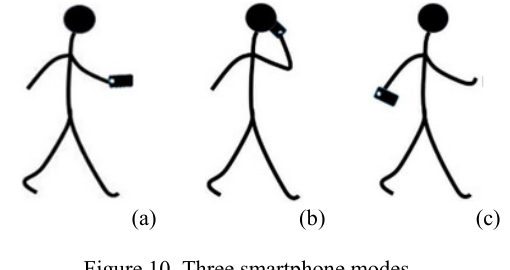
Figure 10. Three smartphone modes